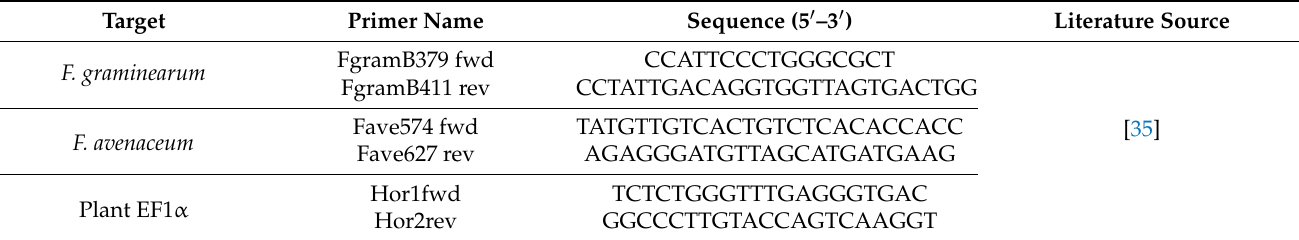
Table 2. Sequences and names of species-specific